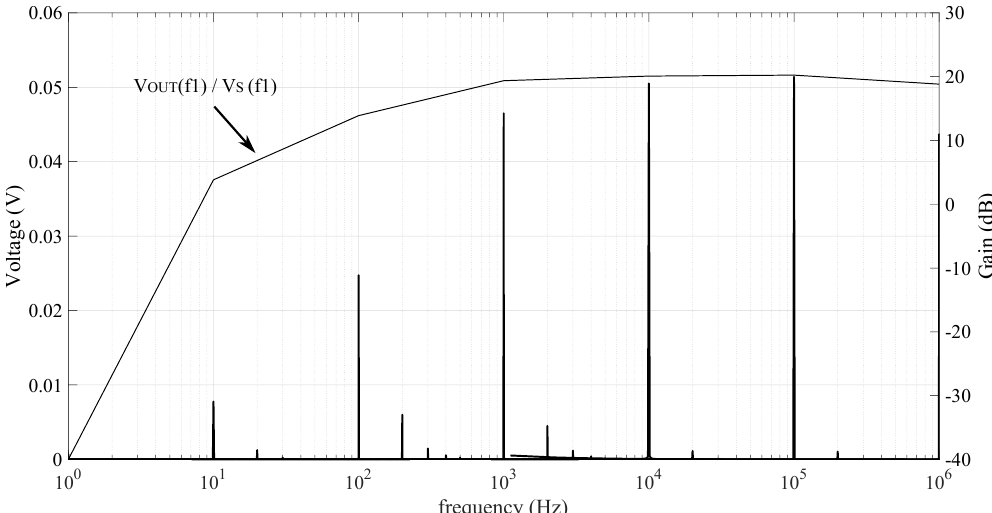
Figure 15. FFT of the output voltage for the input frequency sweep and frequency response of the PFGA. C L = 10 pF, C IN = 100